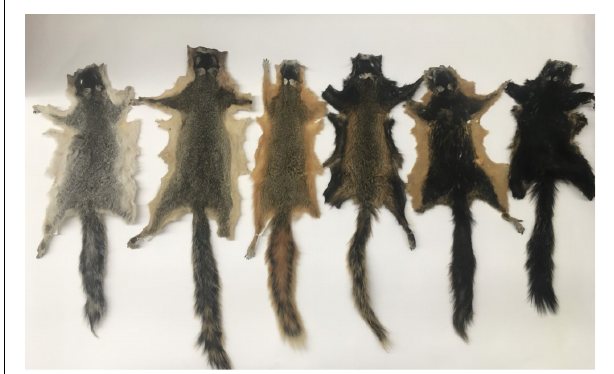
FIGURE 1 | Exemplars of the six fox squirrel color morphs found in Florida. From left to right, gray, agouti with partial dorsal melanism, buff/tan, black-bellied, dorsal melanism,